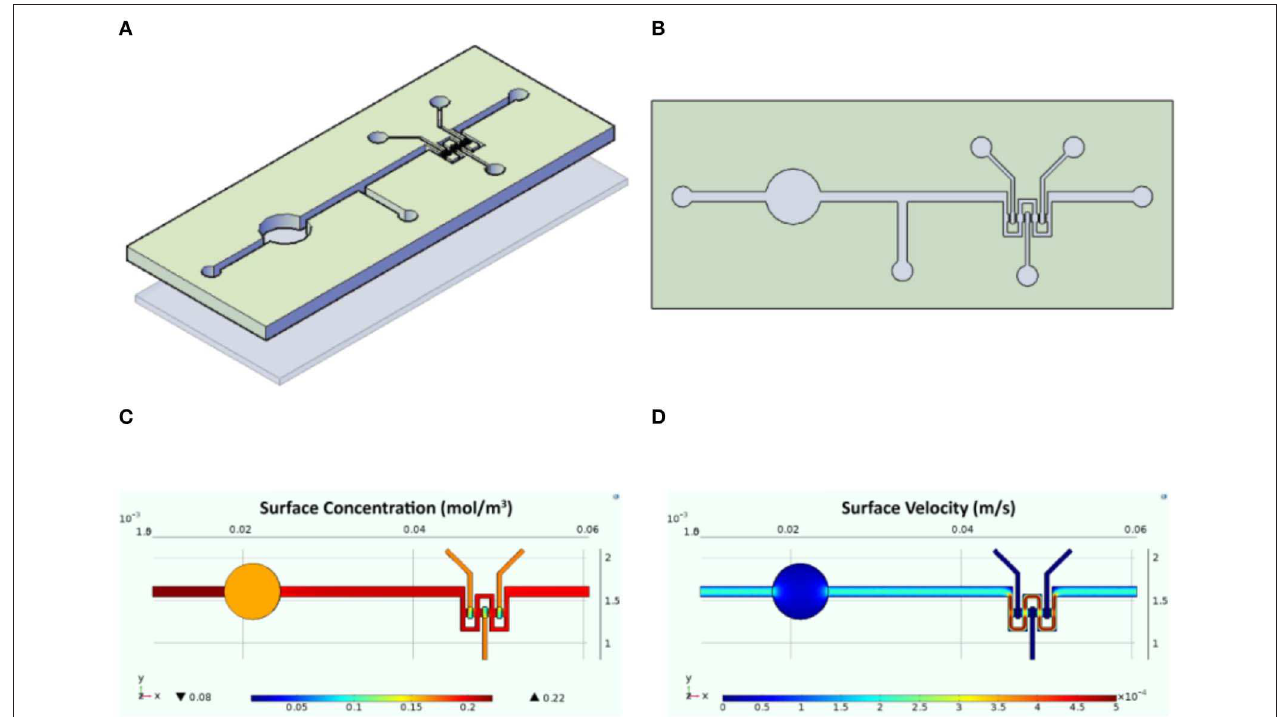
FIGURE 2 | Schematic representation of the InLiver-OC and CFD study. Lateral (A) and top (B) view of the InLiver biochip with Intestine c (In c ) and Liver c (Liv c ); fluid dynamic simulation indicates the velocity field in the device system at a flow rate of 5 µ L/min (C) and the oxygen concentration field in the device working at a flow rate of 5 µ L/min (D)